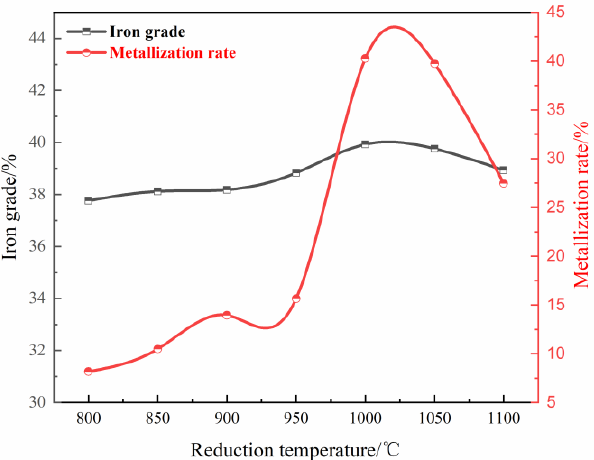
Figure 4. Effects of reduction temperature on the pre-reduction indices. (Reducing for 60 min, with a C/Fe mass ratio of 1.50, natural basicity of 0.0020).